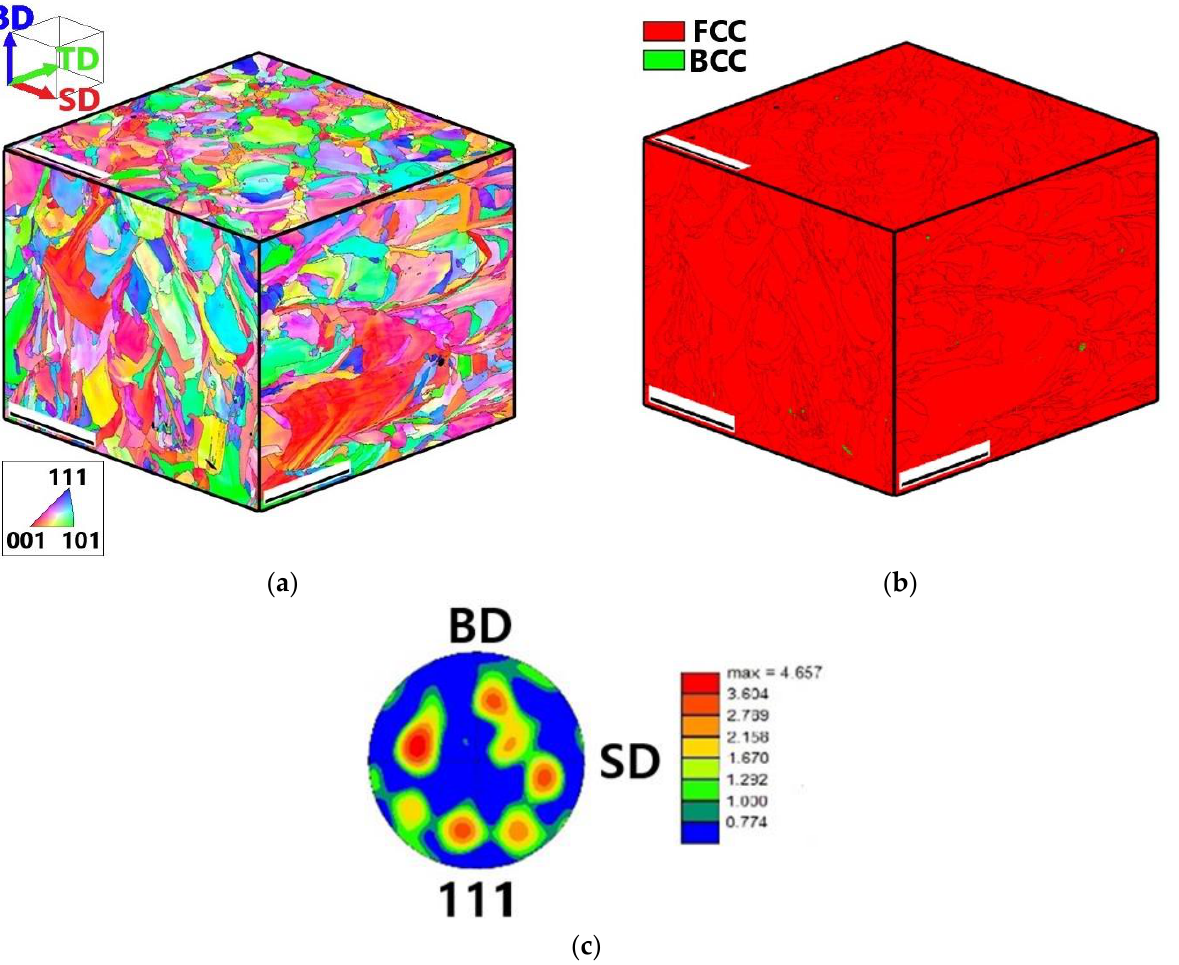
Figure 7. Quasi-3D microstructures of the as-produced (mode: P = 200 W and V = 1600 mm/s) Fe 65 (CoNi) 25 Cr 9.5 C 0.5 alloy: IPF ( a ), phase maps ( b ) and (111) pole figure of the fcc matrix phase ( c ). The scale bars in ( a , b ) is 100 μm.